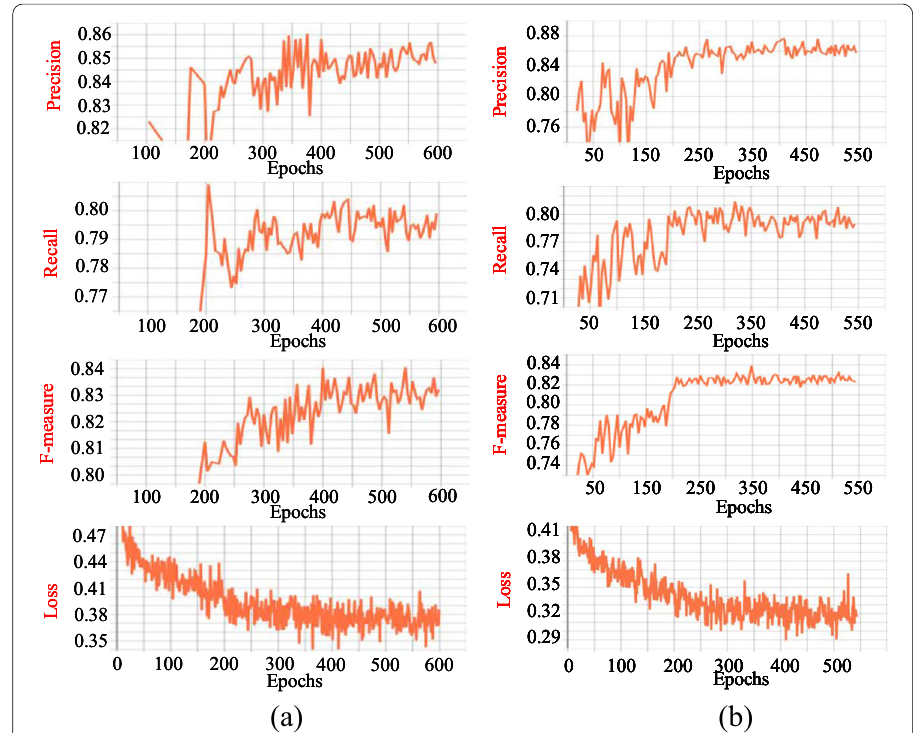
Fig. 5 Performance comparison between ResNet-152 and the optimized ResNet-MPM-50: a is PSENet backbone network of ResNet-152; b is PSENet backbone network of the optimized ResNet-MPM-50